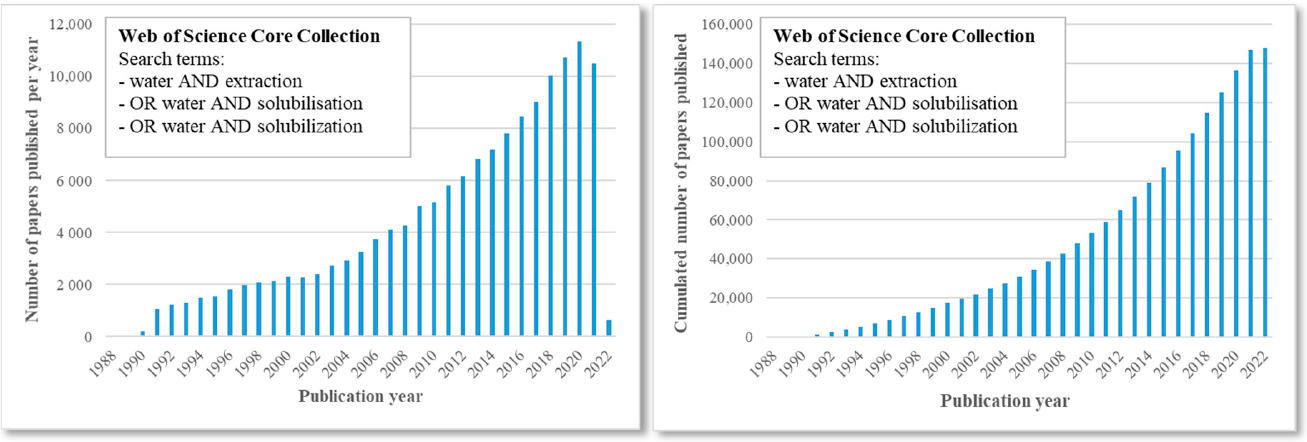
Figure 1. Search results depicting the total number of publications published per year ( left ) and the cumulated number by year ( right ) related to solubilisation and/or extraction using water as a solvent. Database: Web of Science Core Collection, time range: 1985–2022.